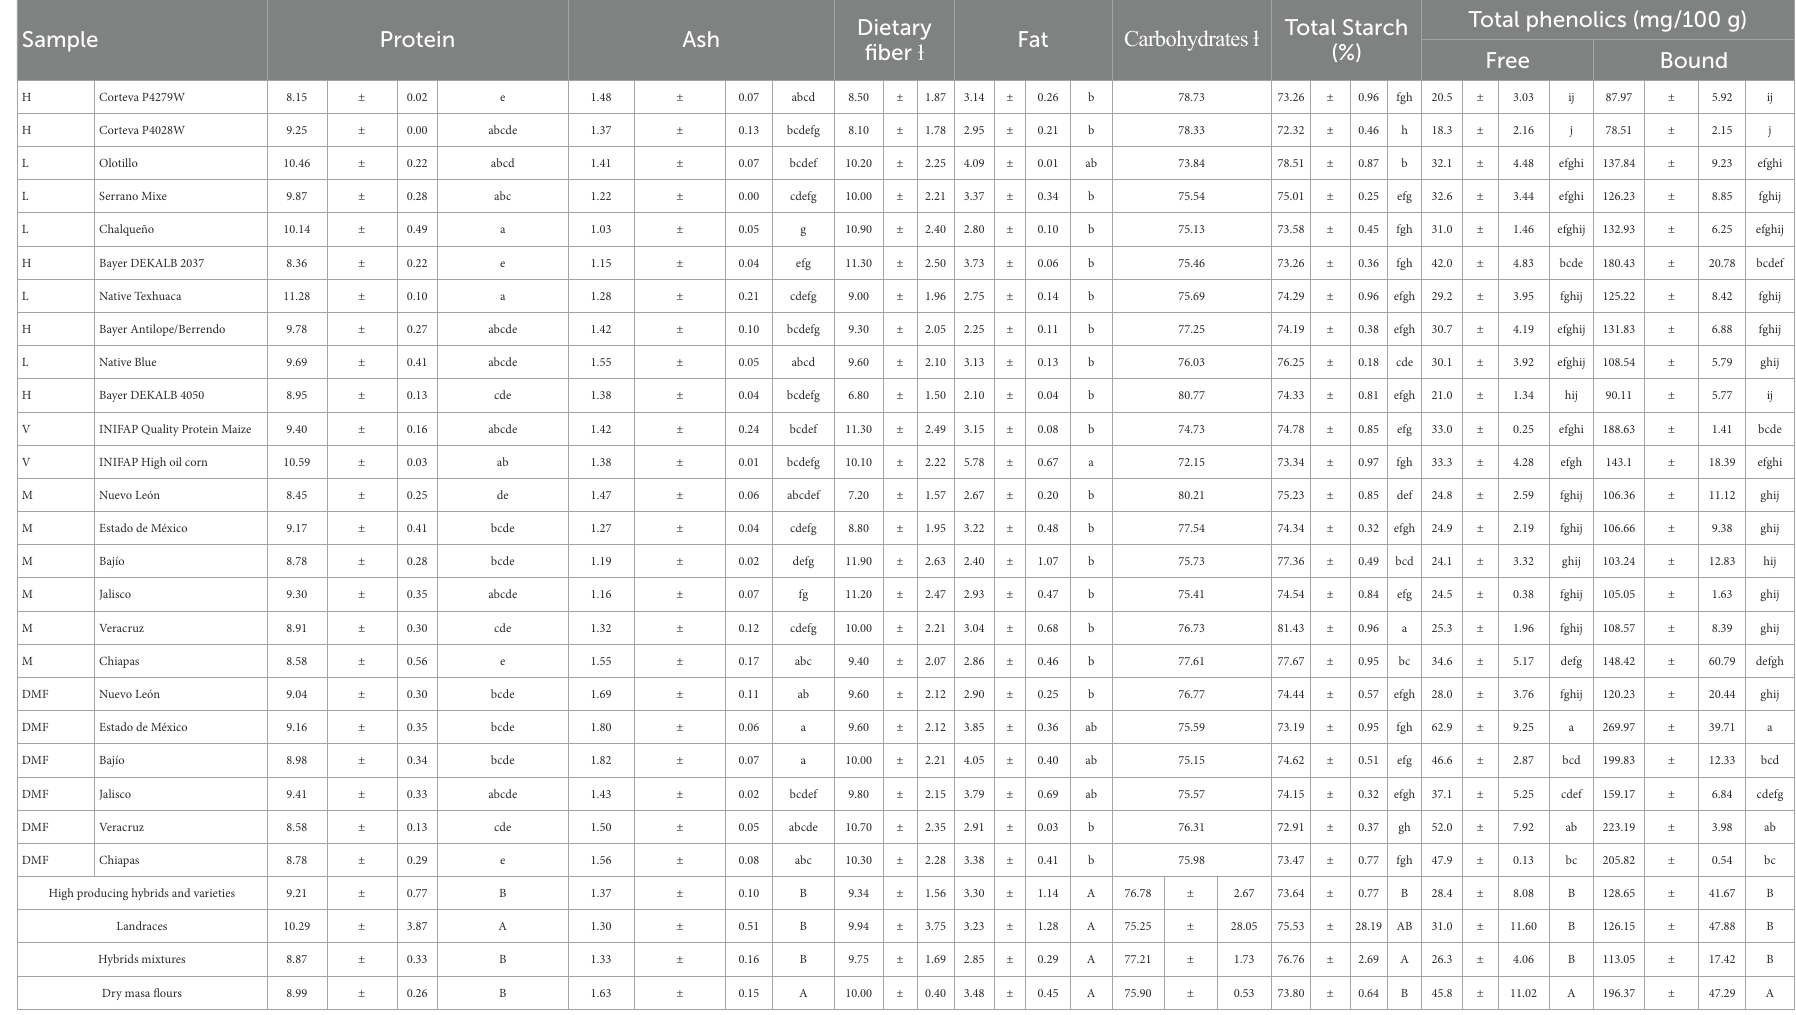
TABLE 5 Analysis of proximate composition and total phenolic content of tortilla samples (dry